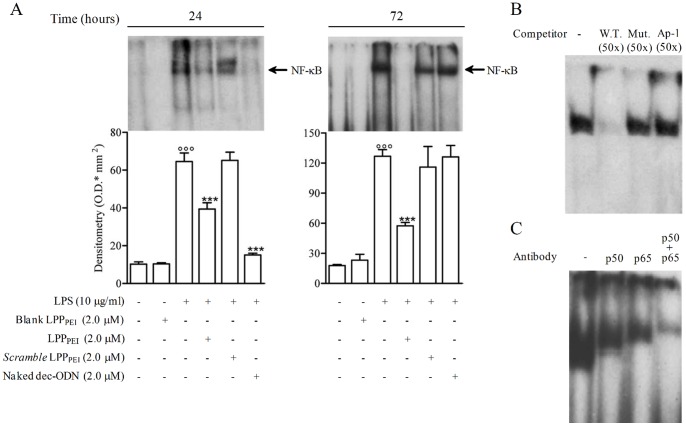
Representative EMSA and corresponding densitometric analysis show the effects of dec-ODN released from LPPPEI or naked dec-ODN decoy on NF-κB/DNA binding activity in LPS-stimulated NCI-H292 cells at 24 and 72 h.Densitometric data are expressed as mean ± S.E.M. of three separate experiments. °°°p<0.001 vs. unstimulated cells; ***p<0.001 vs. LPS alone. (B-C) Characterization of NF-κB/DNA complex was performed on nuclear extracts from LPS-stimulated NCI-H292 cells at 24 h (W.T. = wild tipe dec-ODN; Mut. = scramble dec-ODN). Plots in (A,B,C) are from a single experiment and are representative of three separate experiments.